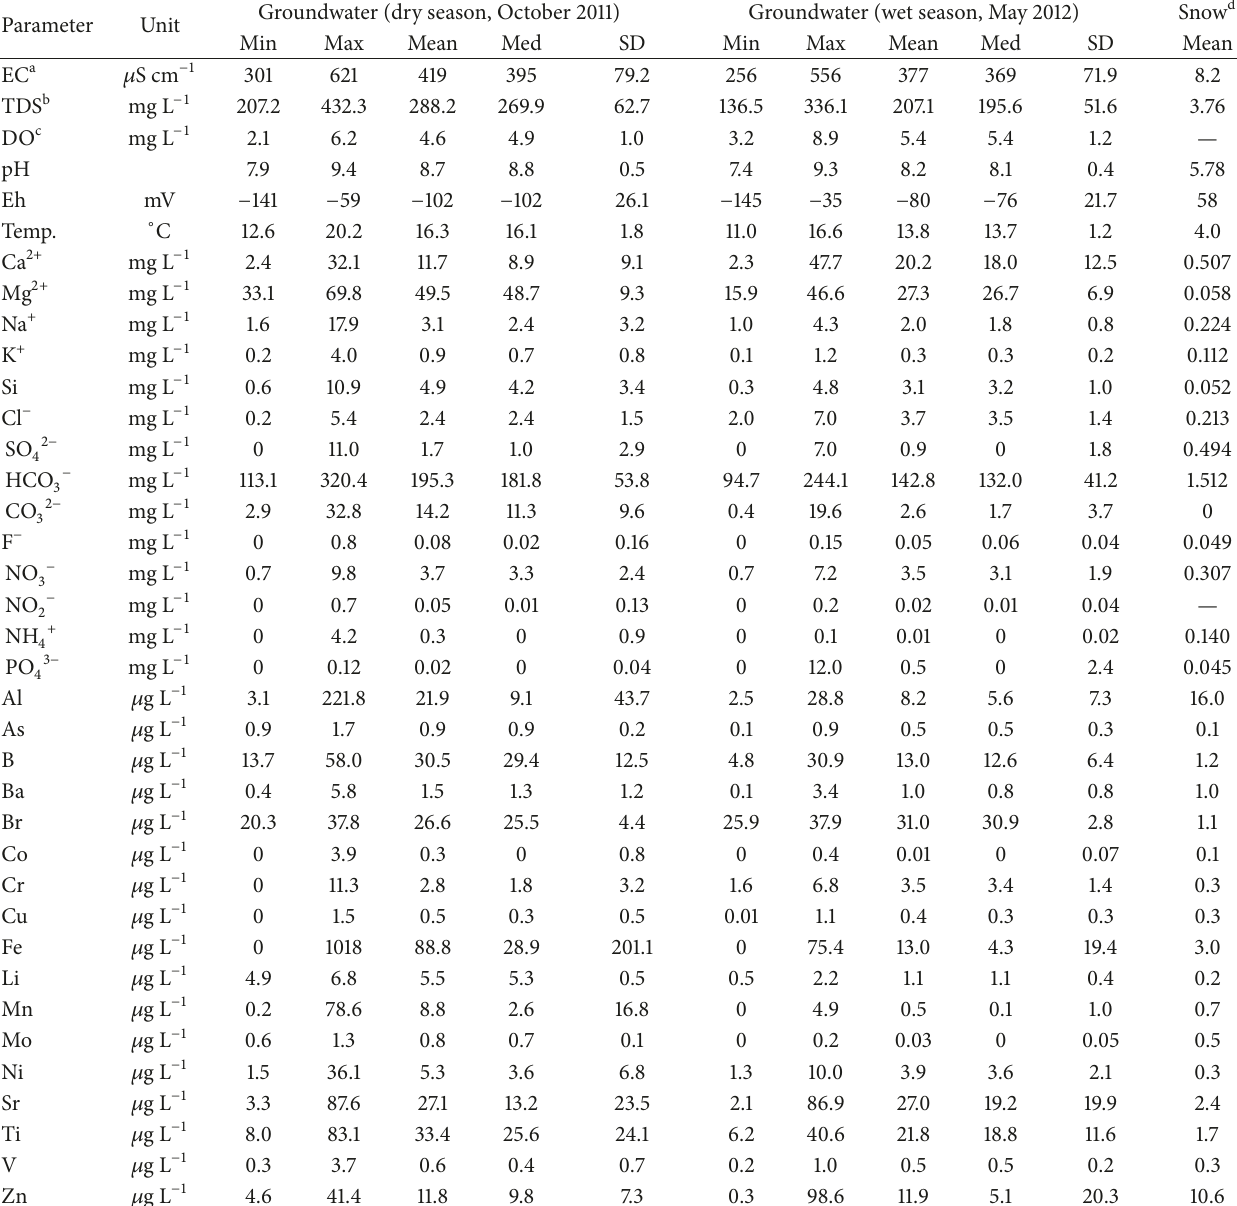
Table 3: Summary of seasonal physicochemical composition of groundwater (from identical hand-dug wells; 𝑛 = 25 ) and snow ( 𝑛 = 11 ) samples collected in the study